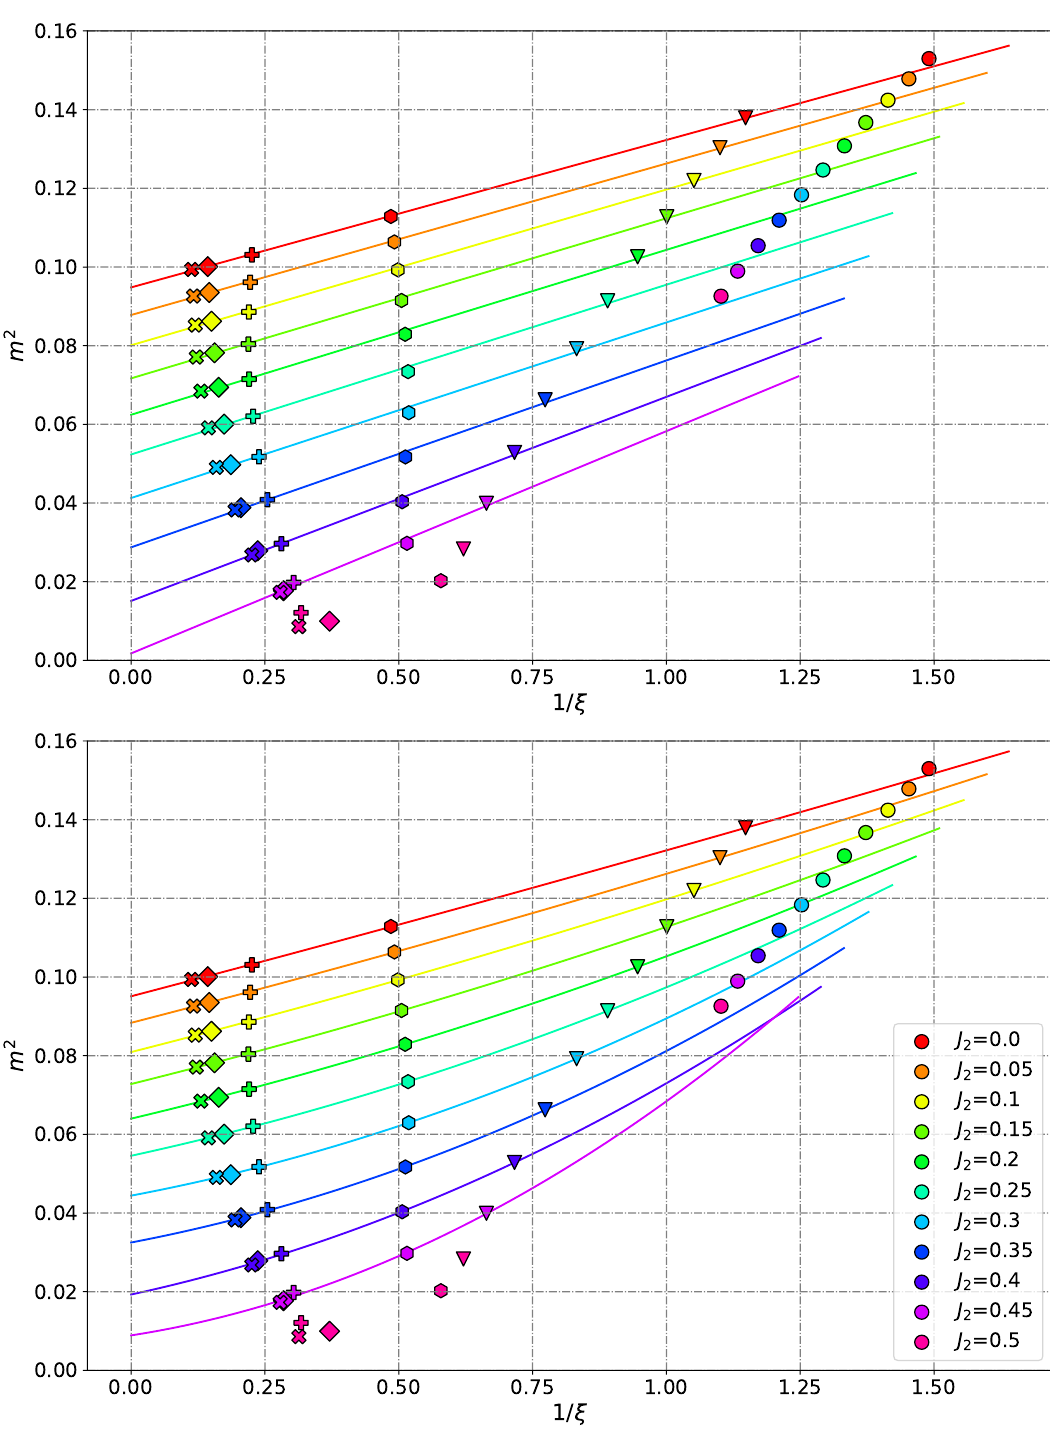
Figure 5: Finite correlation-length scaling of the magnetization for the C symmetric U ( 1 ) iPEPS Ansatz with bond dimensions D = 2,...,7 (denoted by cir- cles, triangles, hexagons, pluses, diamonds, and crosses in the same order). The magnetization is plotted as a function of 1 /ξ , expected in the magnetically ordered phase [ 41 ] . Linear (quadratic) extrapolations of magnetization, excluding D = 2 data, are reported in the top (bottom) panel, except for J